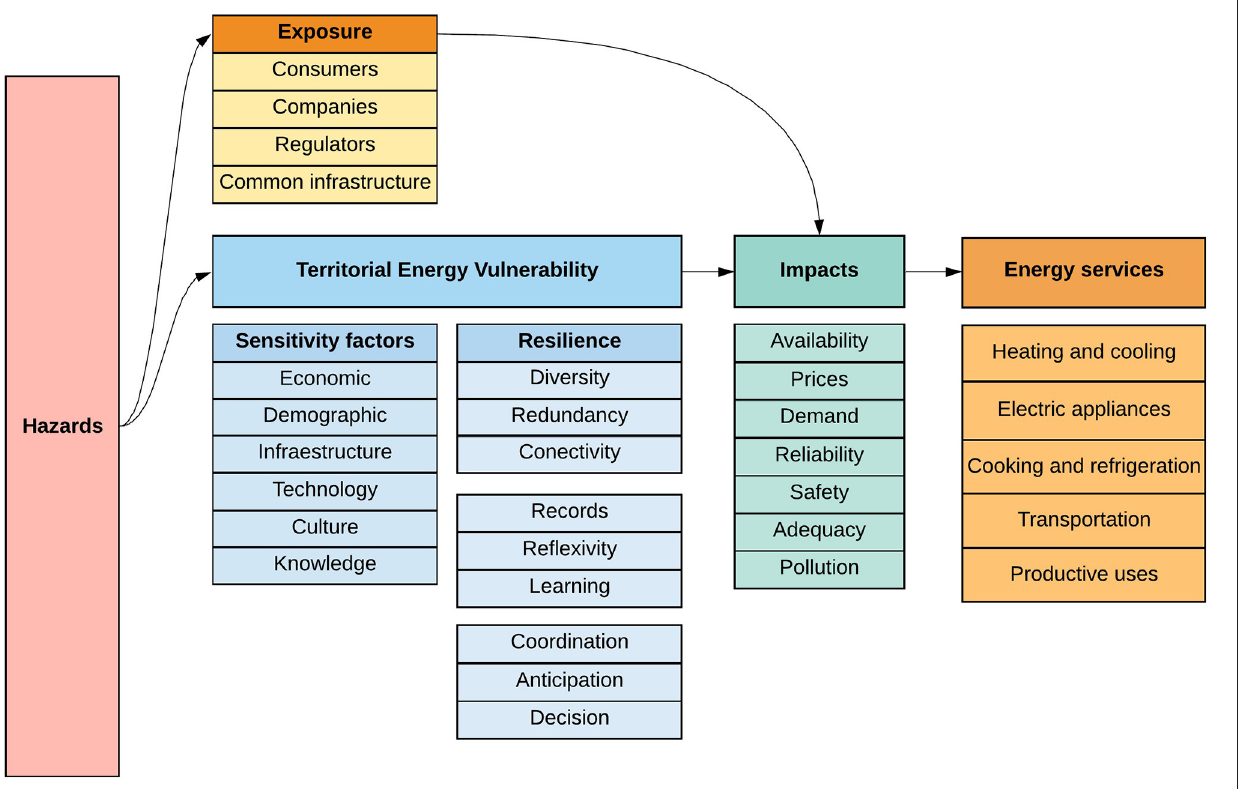
FIGURE 2 | Schematic representation of territorial energy vulnerability. Source: adapted from Red de Pobreza Energética